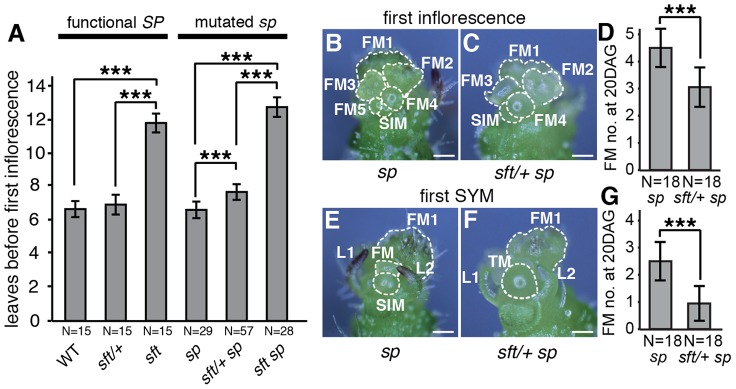

sft/+ heterozygosity induces weak semi-dominant delays in both primary and sympodial flowering transitions.(A) sft/+ sp plants show slightly delayed primary shoot flowering time compared to sp as measured by leaf production before formation of the first inflorescence. Note the extremely delayed flowering of sft sp double mutants, indicating a weak semi-dominant effect for sft/+ heterozygosity. Bars indicate average leaf numbers with standard deviations. Genotypes and sample sizes are shown below. Statistical differences were tested by Wilcoxon rank sum tests and significance levels are marked by asterisks (***P<0.001). (B–G) Representative images and quantification of developmental progression (ontogeny) of meristems in the first inflorescence and sympodial shoot meristems (SYM) of sp (left images) and sft/+ sp plants (right images) at 20th DAG. Both sp (B) and sft/+ sp (C) PSMs have completed the primary flowering transition and generated a series of floral meristems (FM) and sympodial inflorescence meristems (SIM) [26], [30]. sft/+ sp plants are consistently one SIM behind ontogenically, consistent with a weak delay in flowering from sft/+ heterozygosity (D). Developmental progression of the first SYM in sp (E) and sft/ + sp (F) plants at the same time point as in B–C. While the SYM of sp mutants has already completed the flowering transition and differentiated into the first or second FM and initiated the next SIM, the SYM of sft/+ sp plants is still transitioning or initiating the first SIM, indicating a developmental delay parallel to the PSM of sft/+ sp plants (G). In D and G, bars indicate average numbers of initiated FMs with standard deviations. Genotypes and sample sizes are shown below. Statistical differences were tested by Wilcoxon rank sum tests and significance levels are marked by asterisks (***P<0.001). Scale bar: 100 um.